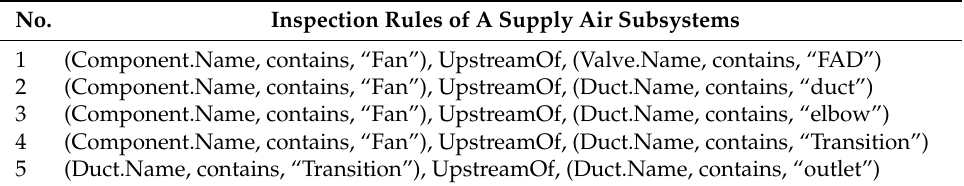
Table 5. Part of inspection rules of MEP